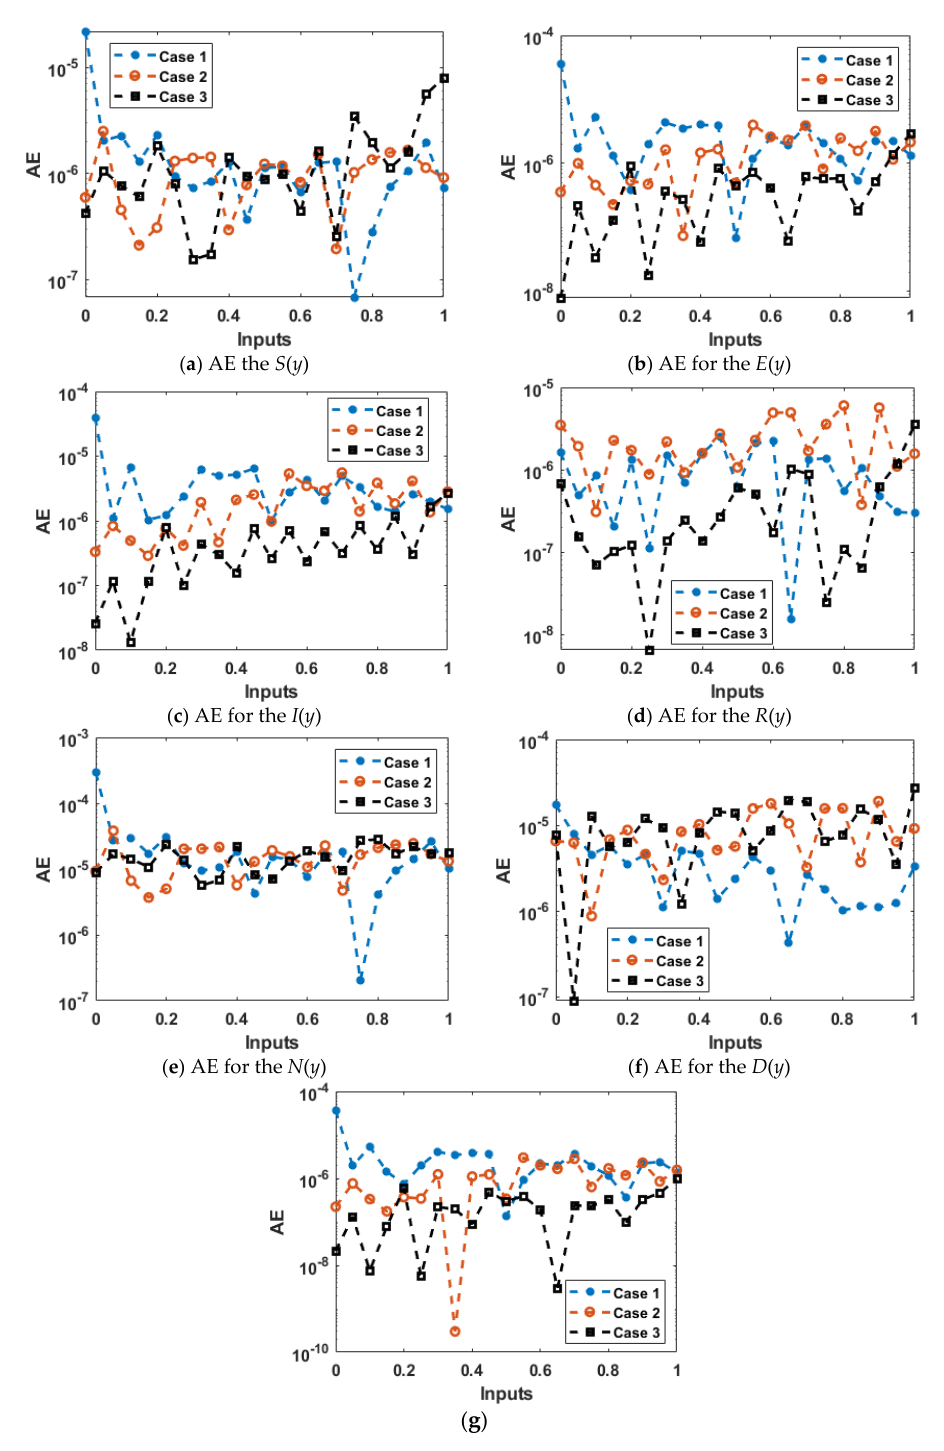
Figure 10. AE using the ANNs-LMB to solve the nonlinear COVID-19 spreading model.